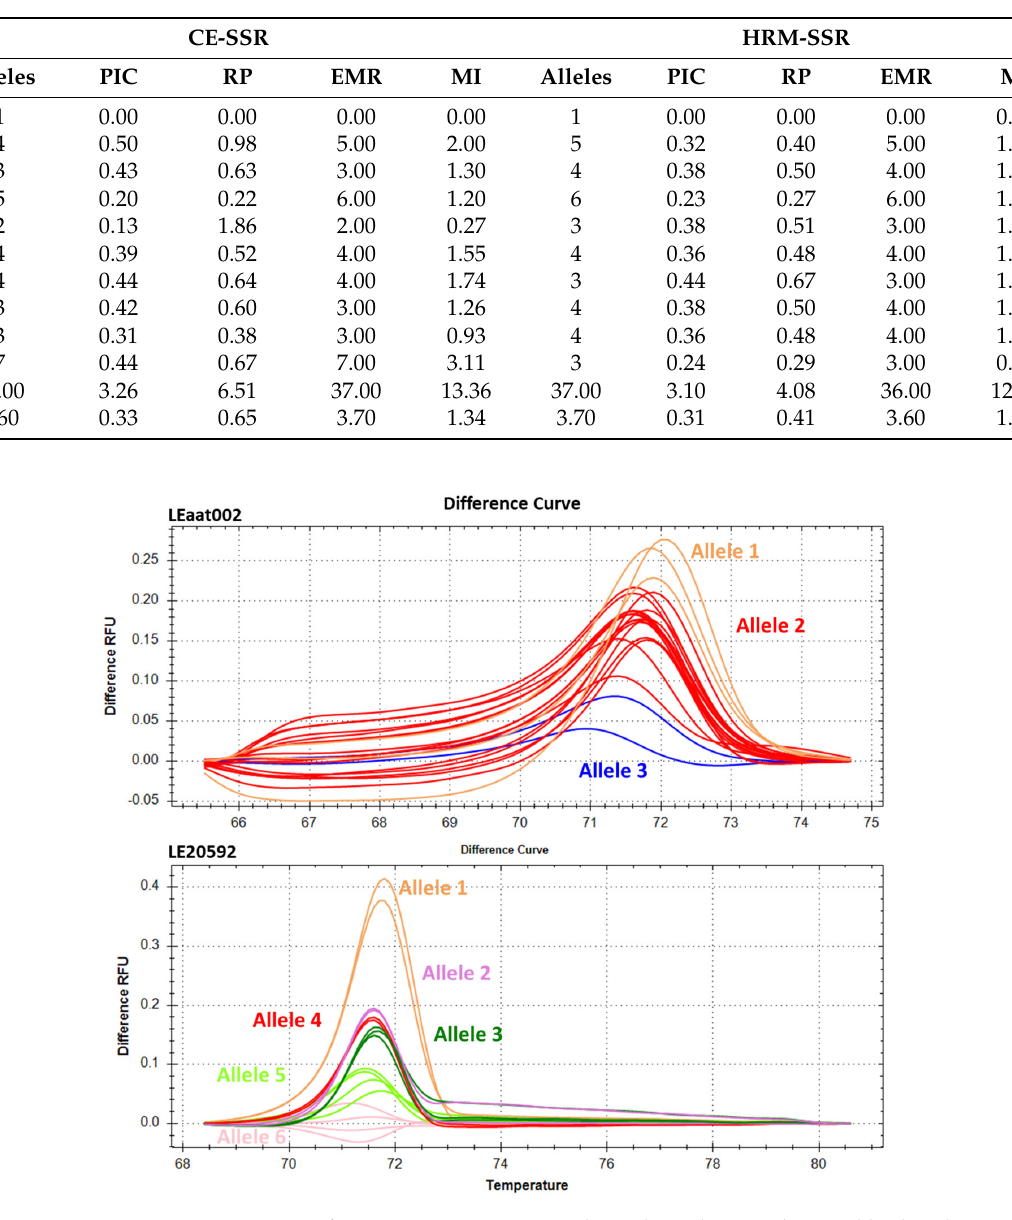
Figure 6. Genotyping of 21 tomato accessions with markers showing low and high polymorphisms based on the resolution melting (HRM) profiles. Curved with different colours correspond to clusters according to cut off confidence value of 95%. From marker statistics each cluster is considered as a separate allele.